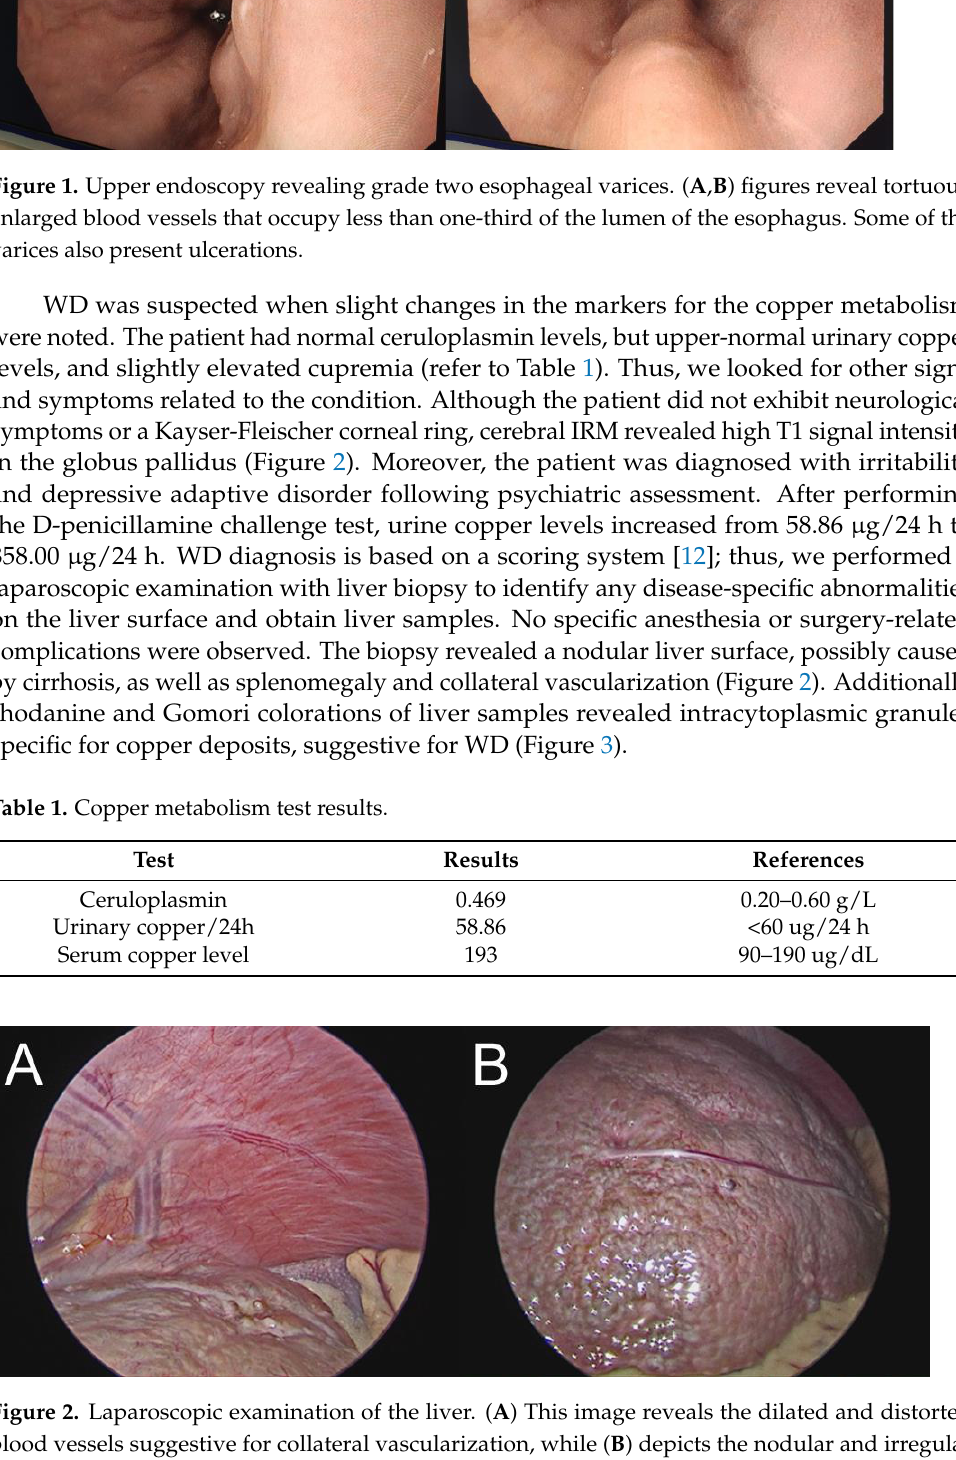
Figure 3. Liver biopsy from our patient presenting with cirrhosis secondary to previously unrecog- nized Wilson’s disease. ( A ): Gomori stain of hepatic tissue showing copper deposits; ( B ): Rhodanine stain of hepatic tissue showing copper deposits. Finally, WD diagnosis was established based on a scoring system [12] describing a positive penicillamine challenge test, psychiatric symptoms, but also a high T1 signal in- tensity in the globus pallidus, and histological liver copper deposits, scoring a total of 5 points, highly suggestive for this disease (Table 2). Table 2. The diagnostic score for Wilson’s disease. Modified after the consensus agreement [12]. Score